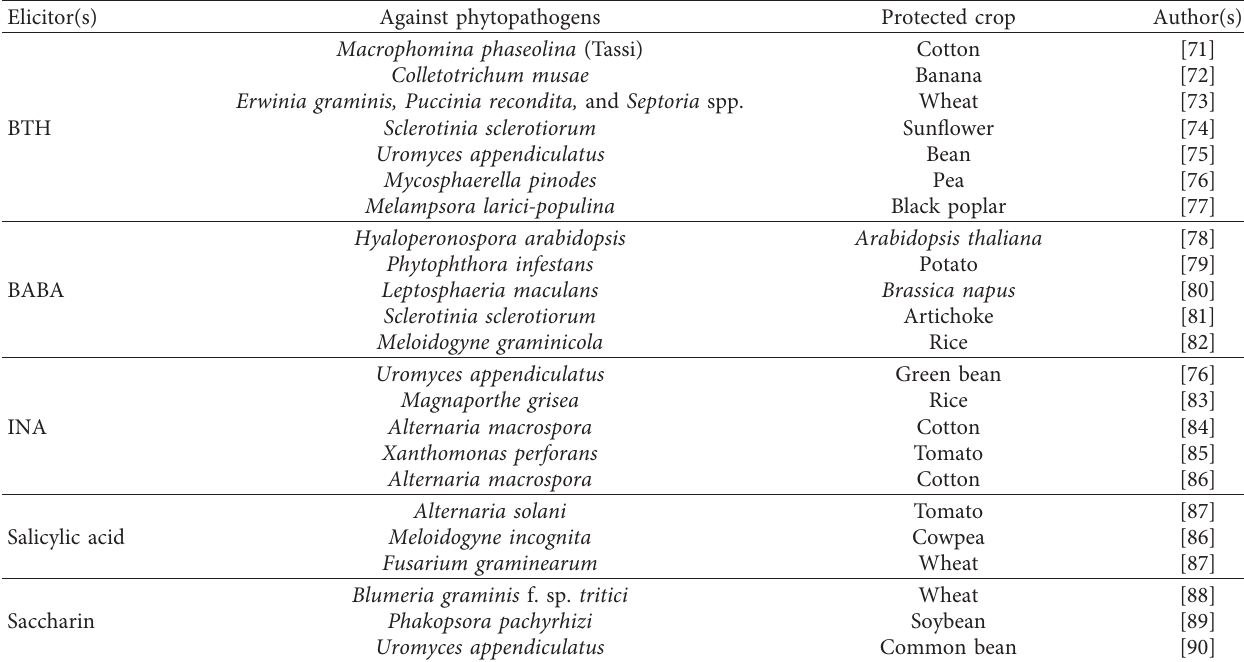
Table 1: Some elicitor chemicals recognized as plant immunity inducer against